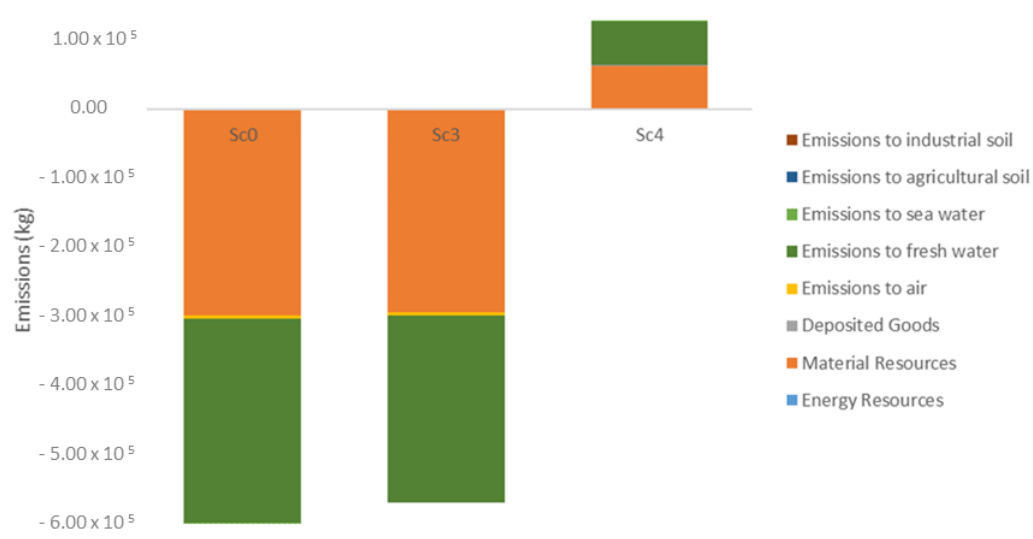
Figure 12. Liikanen et al. [65] reported the major contribution of landfill to the increase of EP impact due to NO x emissions, as well as GWP worsening in the absence of landfill gas collection.